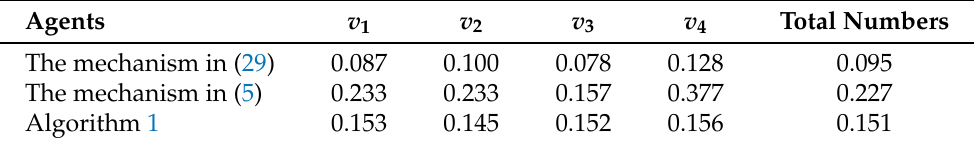
Table 2. The average sampling intervals under the triggering mechanisms (29), (5), and Algorithm